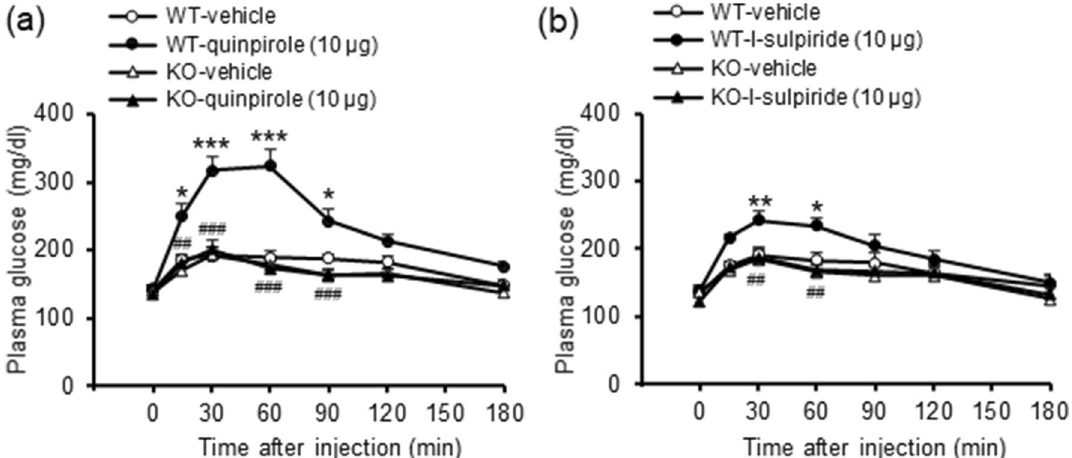
Figure 2. Effects of the dopamine D 2 receptor agonist and antagonist on plasma glucose levels in dopamine D 2 receptor knockout mice (KO). Effect of quinpirole (10 μg, i.c.v.; a ) and l-sulpiride (10 μg, i.c.v.; b ) on plasma glucose levels in wild-type mice (WT) and KO mice. Each point represents the mean ± S.E.M. of 6–8 mice. * P < 0.05, ** P < 0.01, *** P < 0.001 vs. WT-vehicle group. ## P < 0.01, ### P < 0.001 vs. WT-quinpirole or WT-l- sulpiride group.